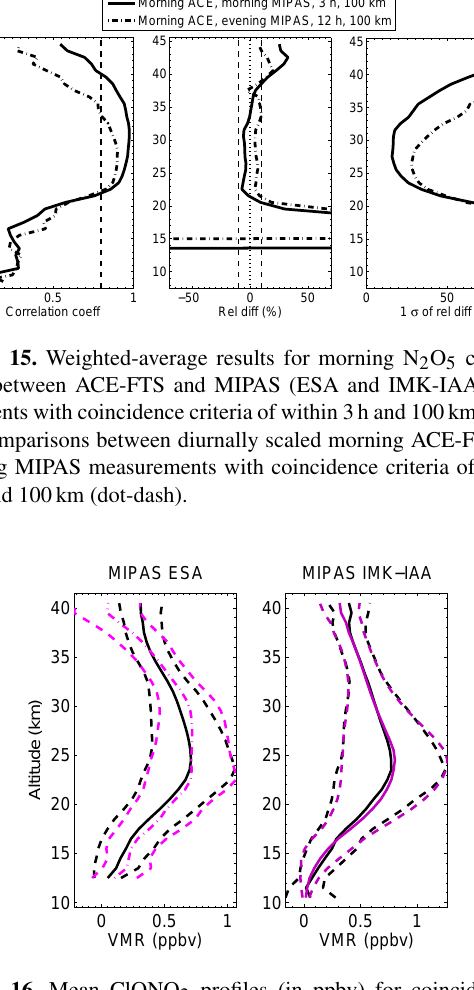
Figure 16. Mean ClONO 2 profiles (in ppbv) for coincident di- urnally scaled ACE-FTS (black) and MIPAS (coloured) measure- ments and corresponding measurement standard deviations (dashed lines). Coincidence criteria for all comparisons are within 4h and